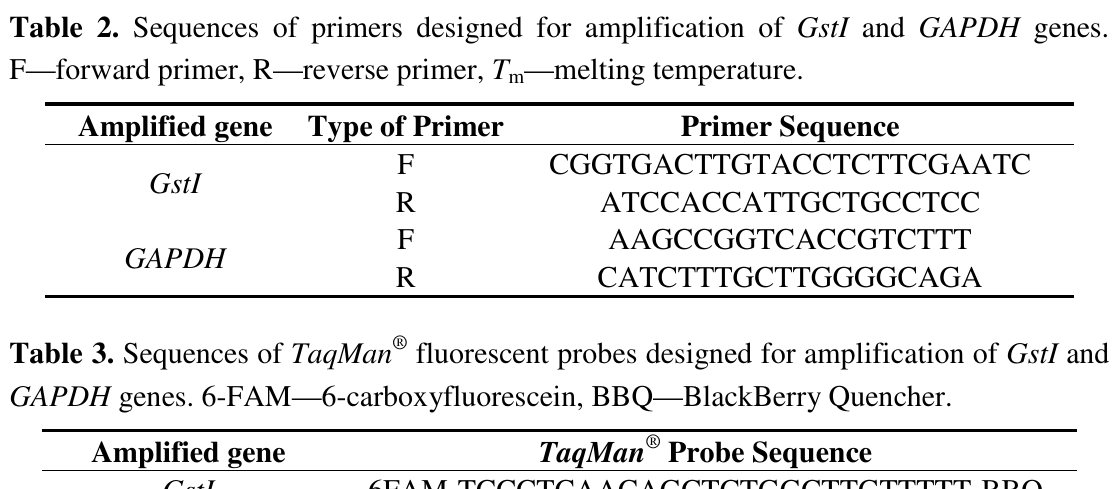
Table 2. Sequences of primers designed for amplification of GstI and GAPDH genes.